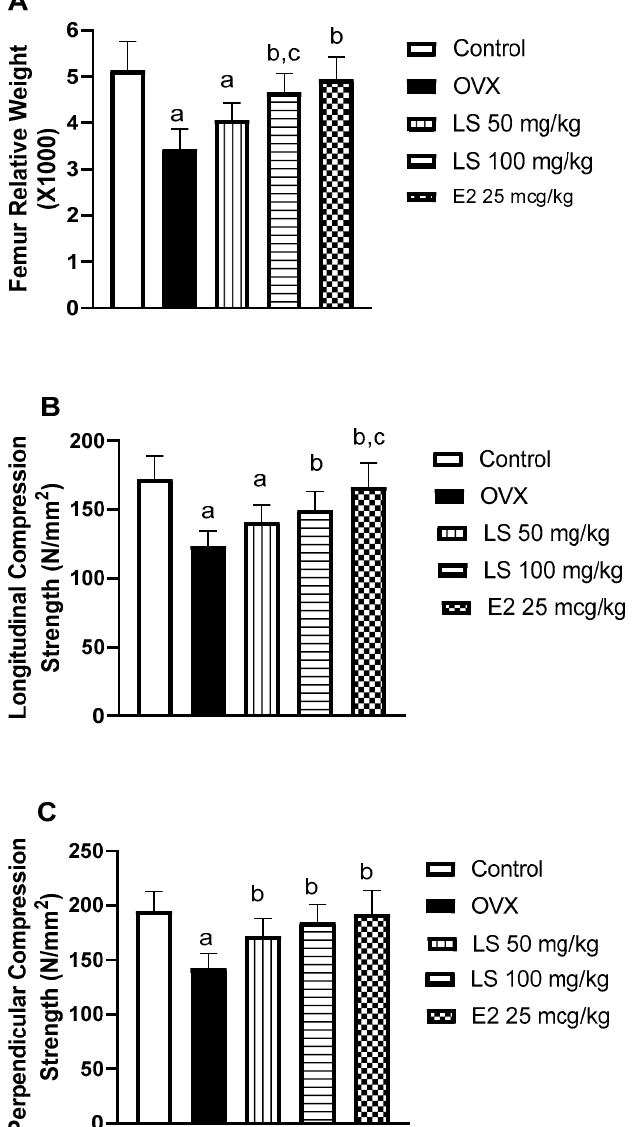
Figure 1. Effect of Lepidium sativum (LS) on femur relative weight and compression strength in ovariectomized rats. ( A ) Femur relative weight, ( B ) longitudinal force, ( C ) femur perpendicular force. Data are presented as Mean ± Standard Deviation (M ± SD). (a) Significantly different from control at p < 0.05. (b) Significantly different from ovariectomized animals (OVX) at p < 0.05. (c) Significantly different from LS 50 mg/kg at p < 0.05.